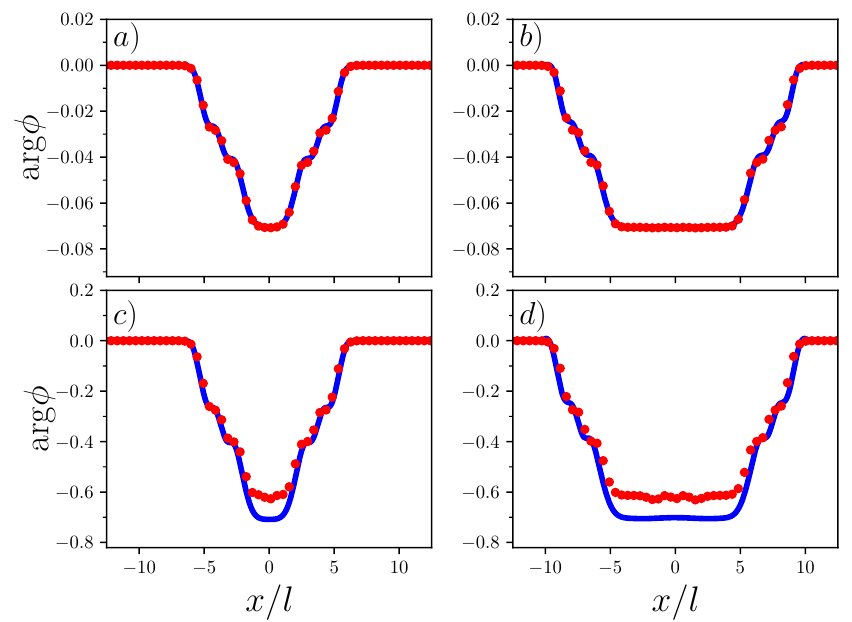
Figure 4: Time evolution of the phase of the Bose gas, arg ( φ ) , in a ring. A solution of the GPE is shown by the solid blue curves; the linearized solution is presented using red dots. The perturbation potential is given by Eq. (27). Numerical calculations are implemented for N = 1500, g = 1.0 taken relative to the phase at x = − L / 2 to ensure that it is well-defined. Panels (a) and (b) show the snapshots at t ≈ { 3.5 (d) demonstrate the phases at t ≈ { 3.5